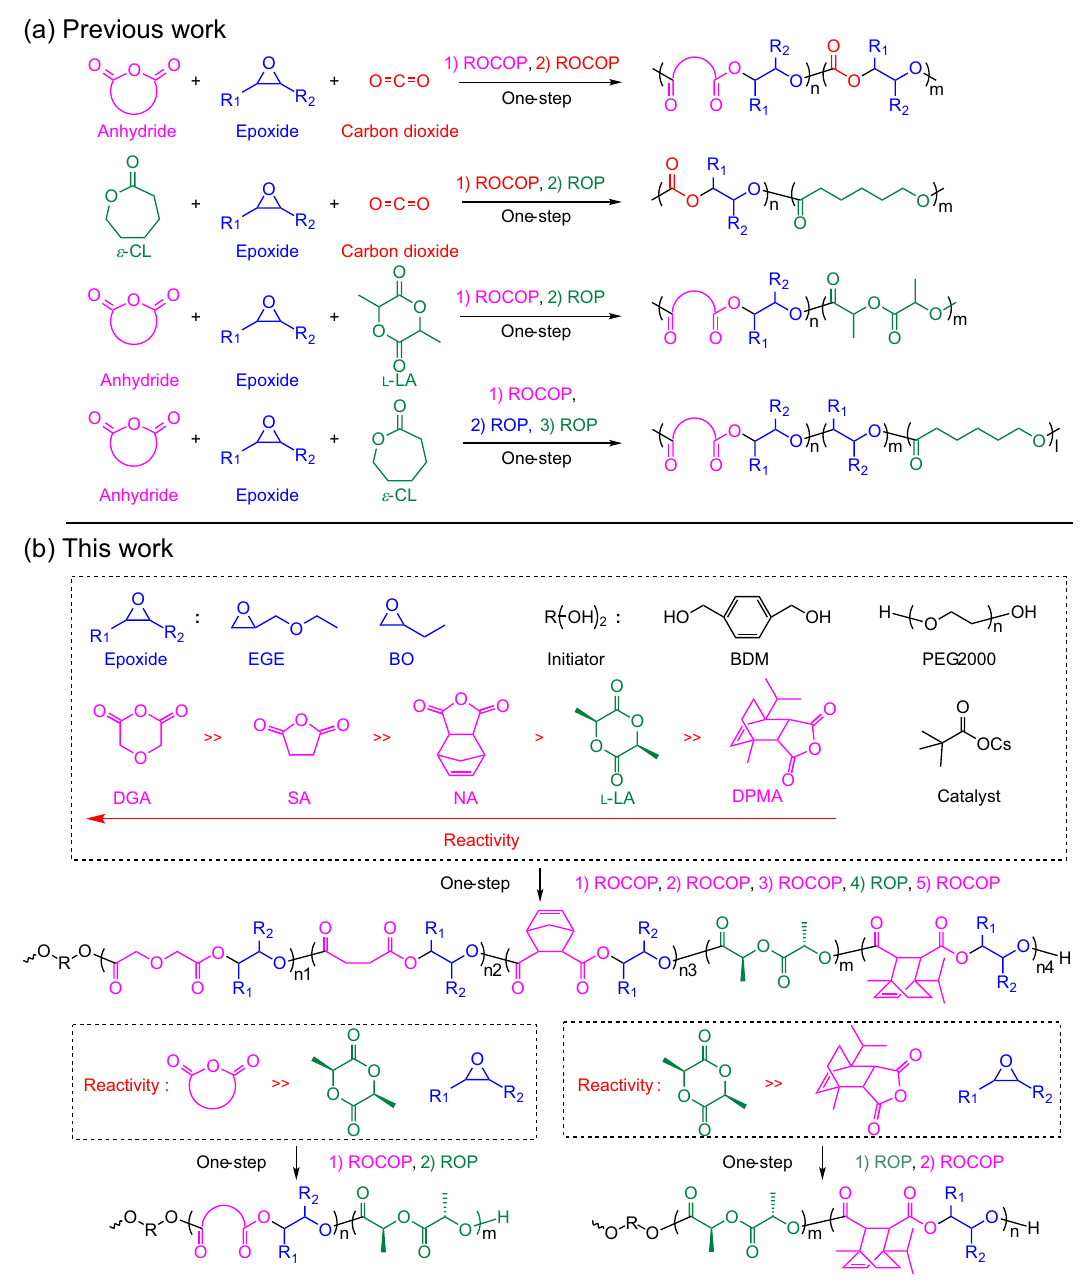
Fig. 1 One-step synthesis of multiblock polymers from a monomer mixture. a Previous strategies are only applicable to three-component monomer mixture. b The strategy presented in this paper provides multiblock polymers from six-component monomer mixture. L -LA L -lactide, DGA diglycolic anhydride, NA 5-norbornene-endo-2,3-dicarboxylic anhydride, EGE ethyl glycidyl ether, SA succinic anhydride, DPMA